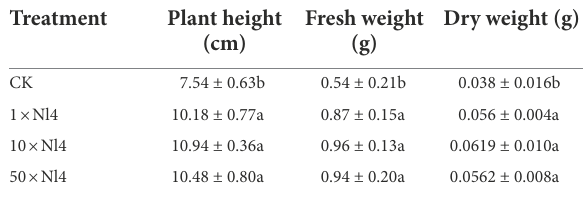
TABLE 1 Effect of P. polymyxa strain Nl4 on tomato growth promotion.